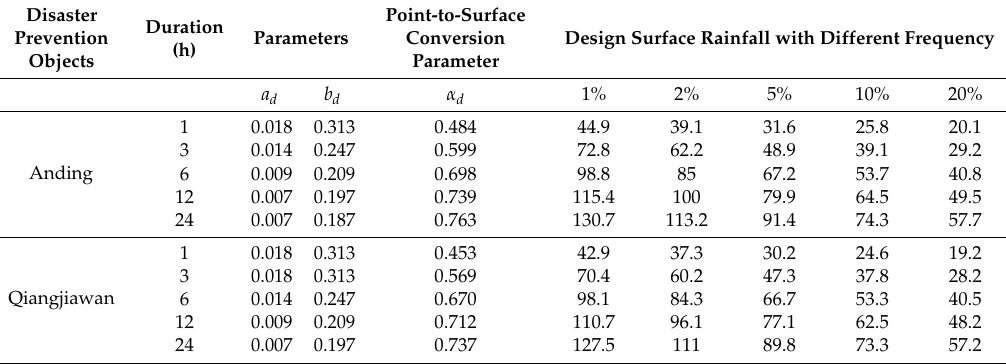
Table 4. Design surface rainfall calculation results with different frequencies.